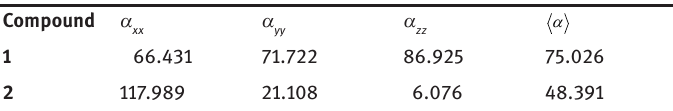
Table 3: Some selected components of the frequency-dependent );( ωωa − and absolute values of );( ωωa − ( a.u. for 1 - 2